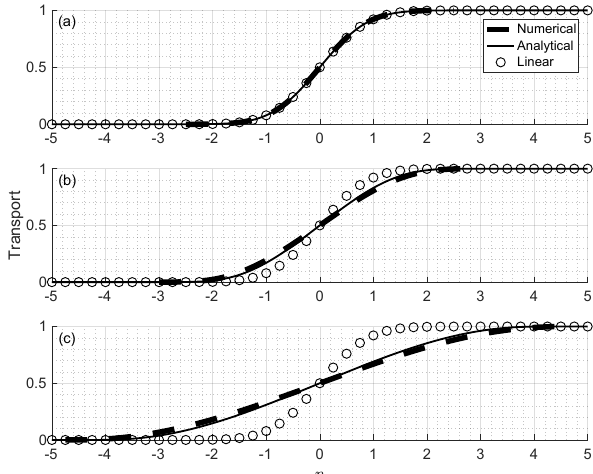
Figure 1. Comparison between linear (open circles), nonlinear nu- merical (thick dashed) and nonlinear analytic (solid lines) normal- ized transport functions. Plotted is the ratio K 2 /K 1 (nonlinear coef- ficient over linear coefficient) of 0.001 (a) , 10 (b) and 100 (c) with K 1 = 0 .